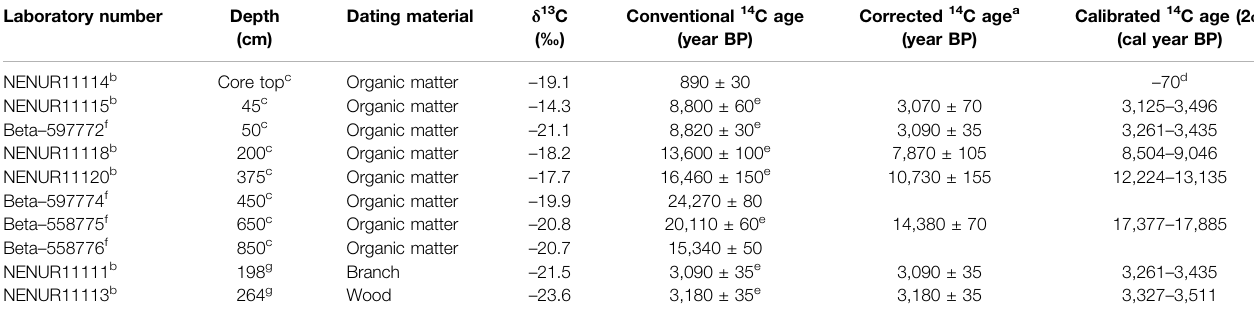
TABLE 1 | Accelerator Mass Spectrometry (AMS) 14 C ages for the Y20A and Y20B cores. Laboratory